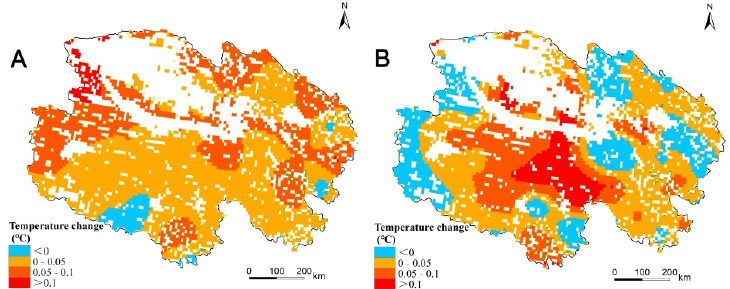
Figure A1. Annual temperature change in the Qinghai grasslands from 1979 to 2000 ( A ) and from 2001 to 2018 ( B ).